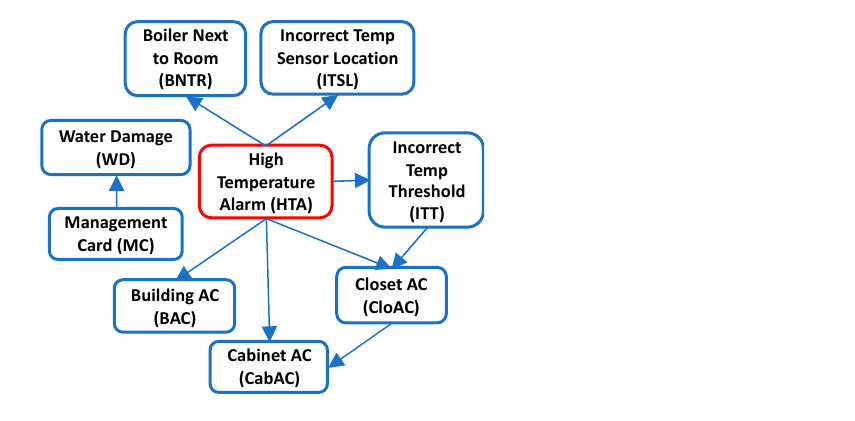
Figure 11. BN for High Temperature Alarm with binary variables using Fusion-learning.